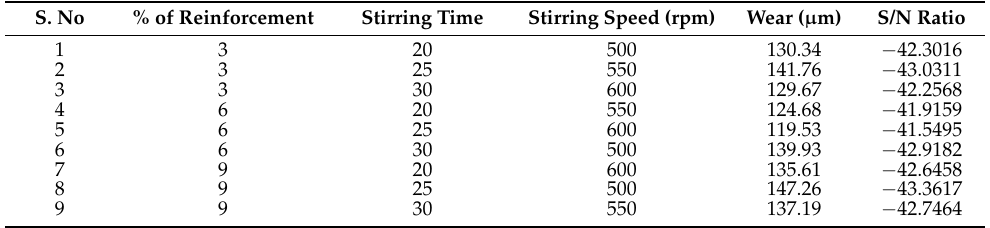
Table 10. Experimental summary of the wear test.